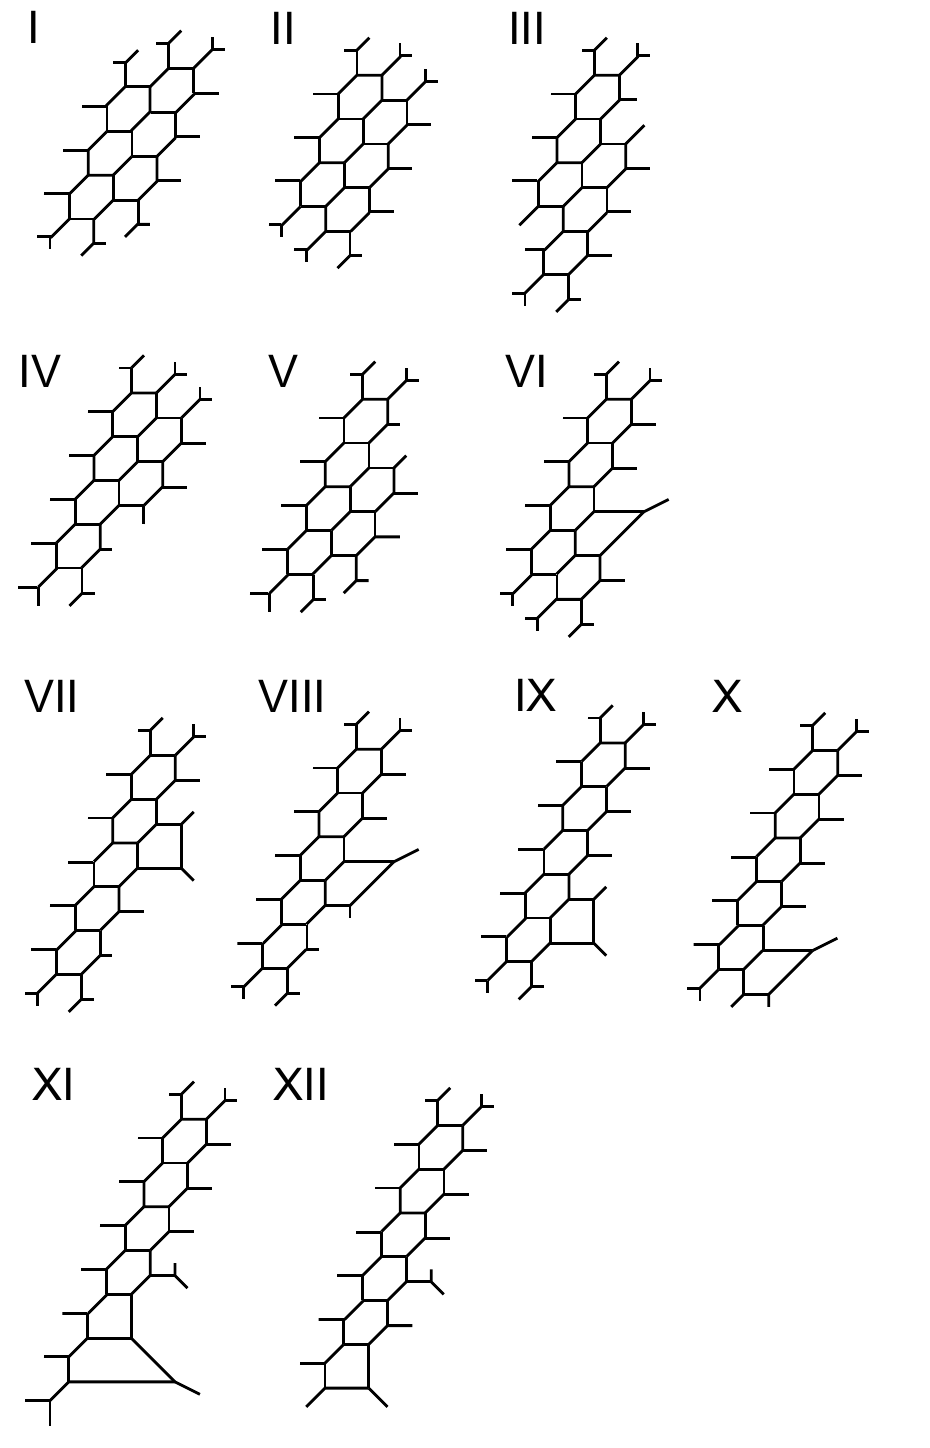
Figure 19 . Chain of